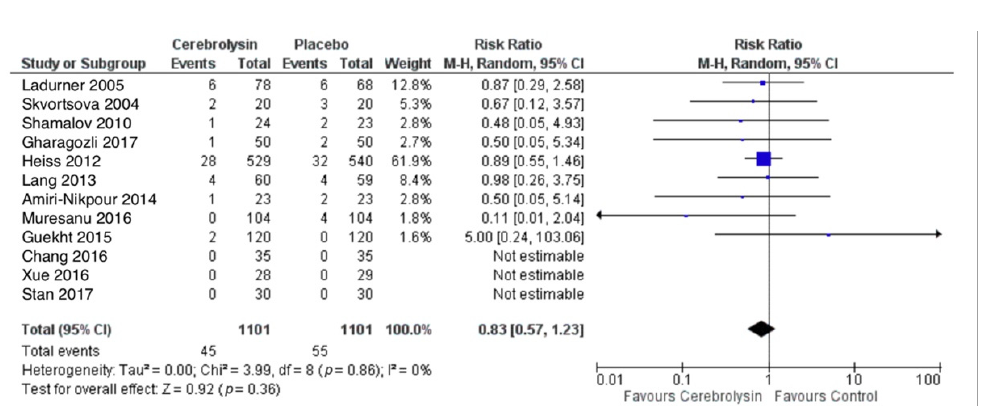
Figure 2. Deaths (All-cause); Comparison of Cerebrolysin versus Placebo, Safety Population, Random Effects, M-H, Risk Ratio (RR).